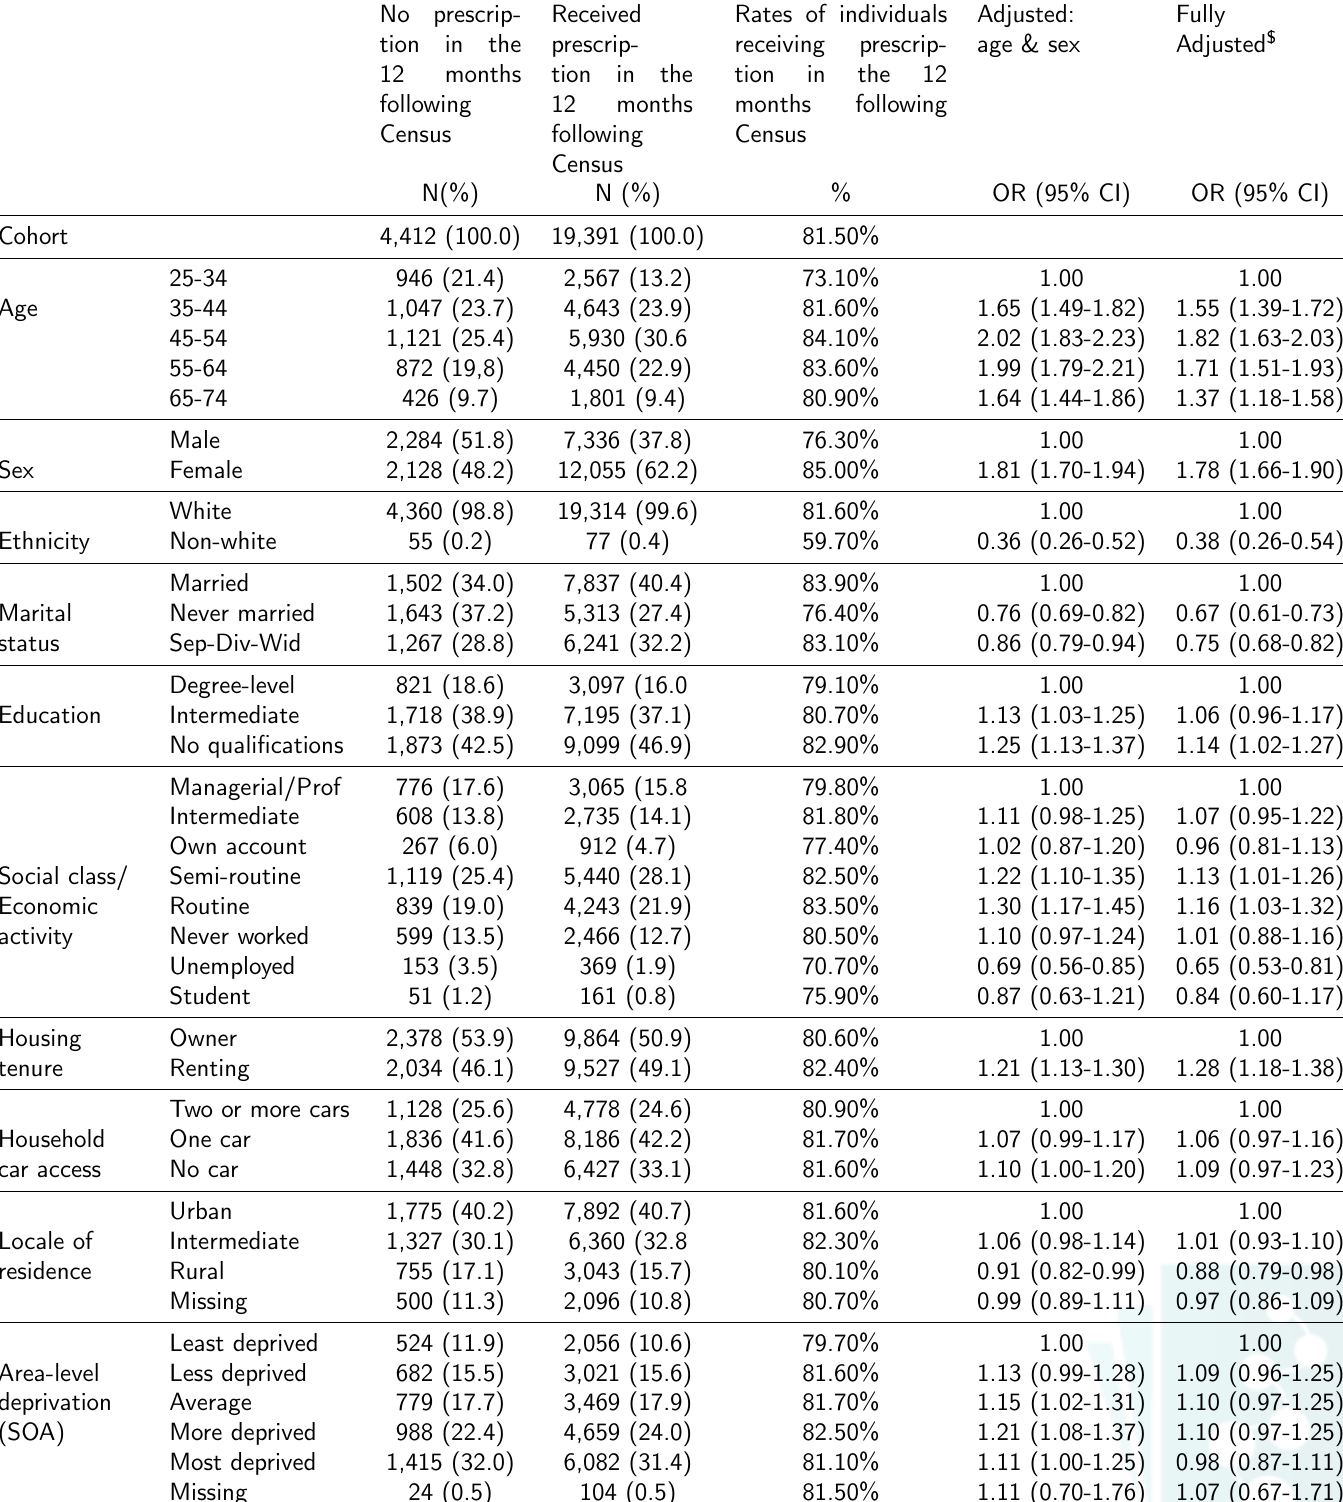
Table 2: Factors associated with the likelihood that people reporting mental health problems at Census receiving psychotropic prescription in the following 12 months. Data represent numbers (percentages) and Odds Ratios (95% Confidence Intervals) from logistic regression